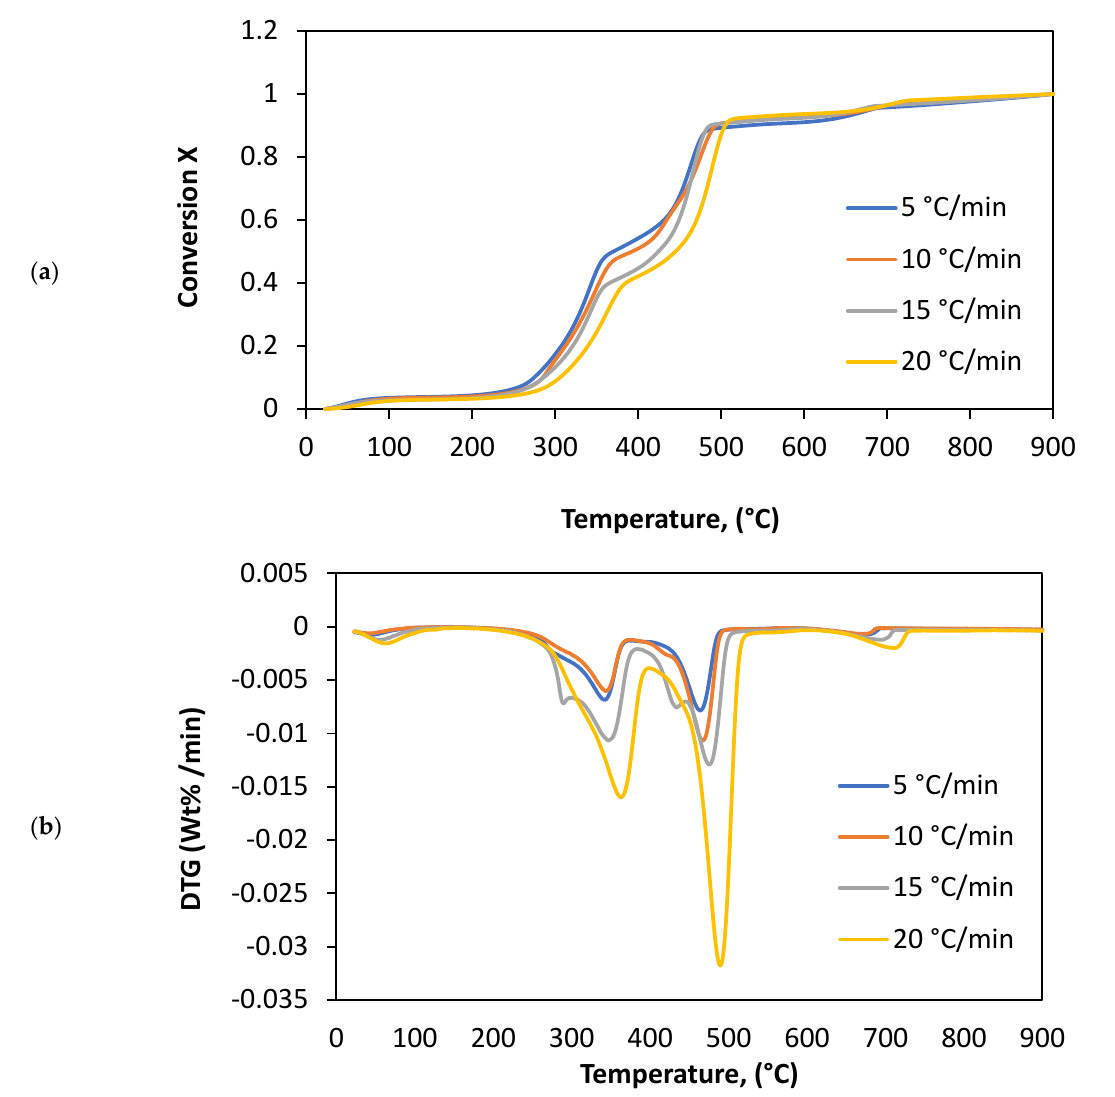
Figure 1. The effect of the heating rate in N 2 : ( a ) conversion degree and ( b ) DTG weight loss.